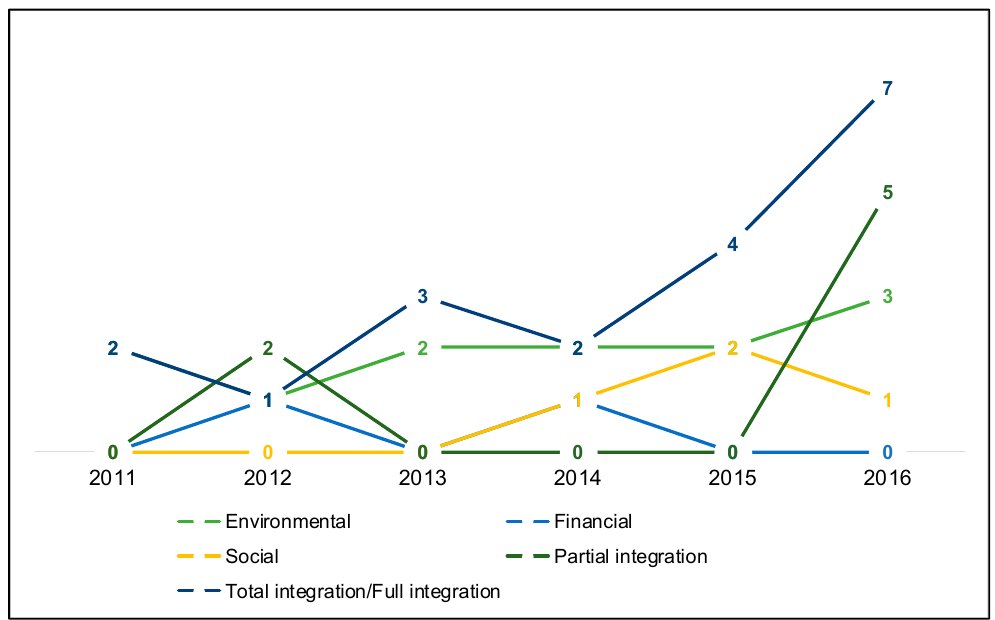
Figure 4. Approach of the dimensions of sustainability.